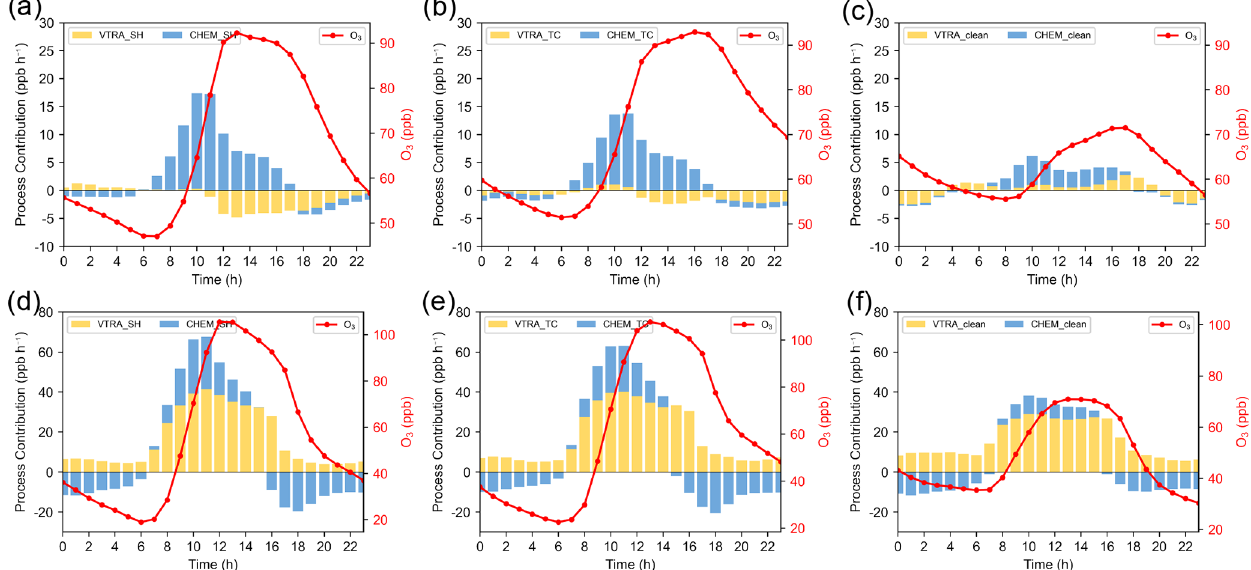
Figure 10. The O 3 concentration (red line) and the contributions of photochemical (CHEM; blue bars) and vertical transport (VTRA; yellow bars) processes to O 3 in the PRD during the subtropical high period (a, d) , typhoon period (b, e) , and clean period (c, f) , where panels (a–c) are the values for all layers above the near-surface layer (35–1260m), and panels (d–f) are the values for the near-surface layer